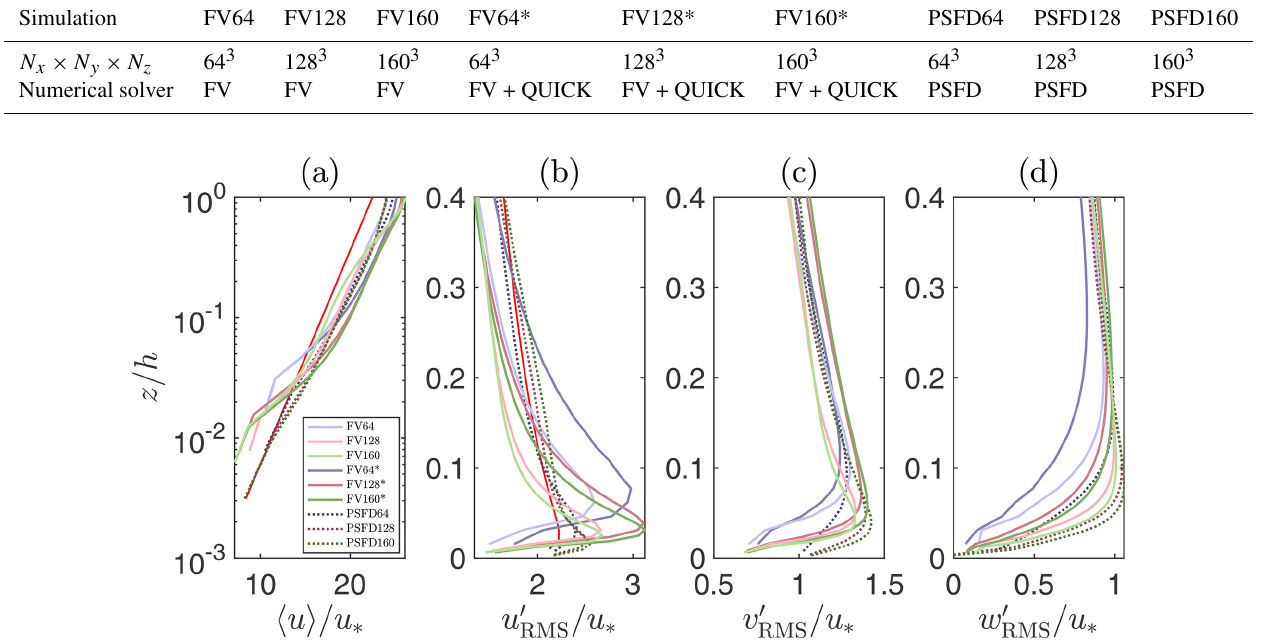
Figure 1. Vertical structure of mean streamwise velocity (cid:104) u (cid:105) /u ∗ (a) , streamwise velocity RMS u (cid:48) v (cid:48) /u ∗ (c) , and vertical velocity RMS w (cid:48) RMS a reference profile from Hultmark et al.